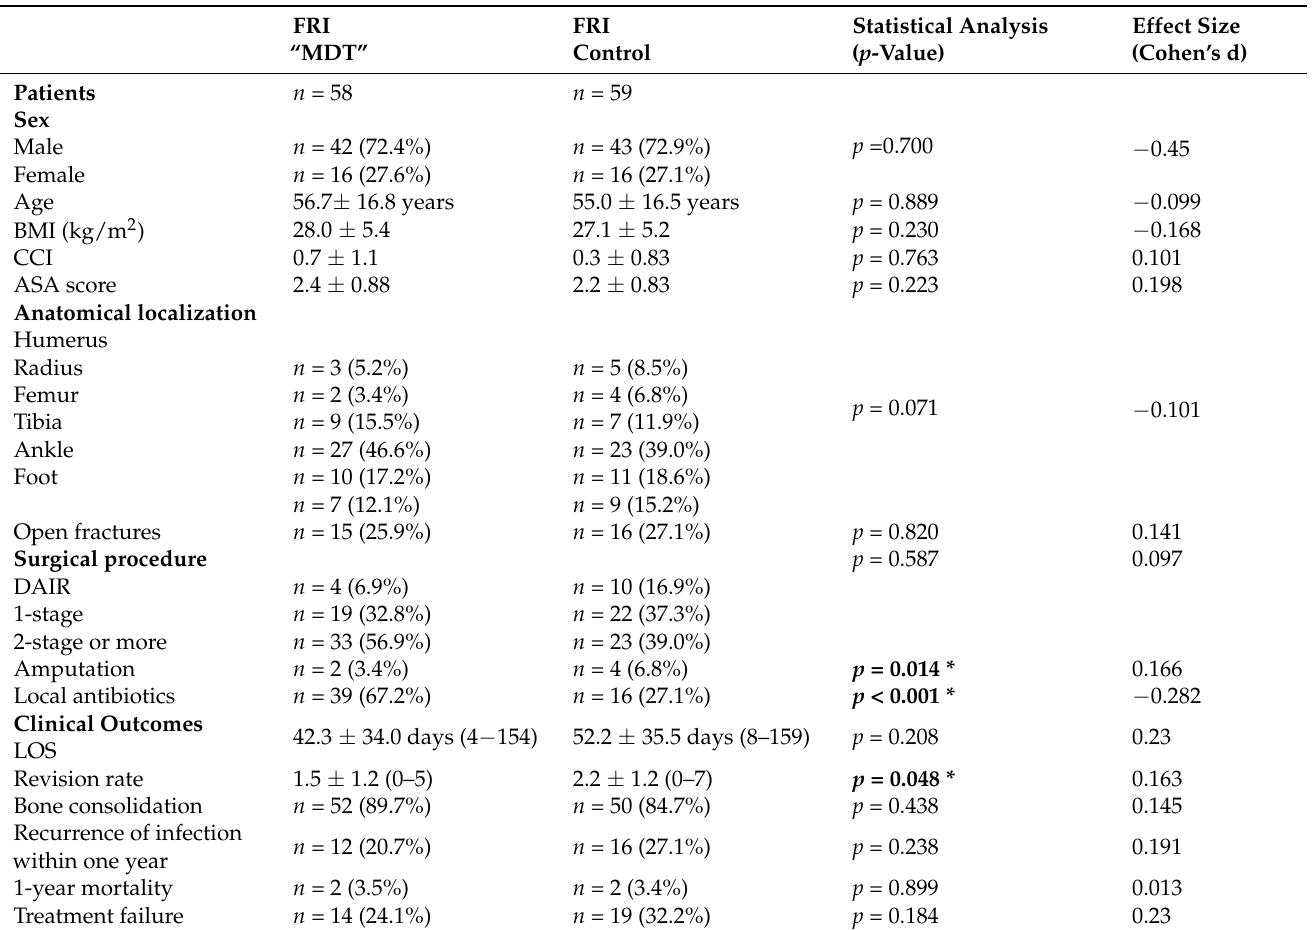
Table 1. Patient characteristics and clinical outcomes of the FRI group managed with a multidisci- plinary team (MDT) and control